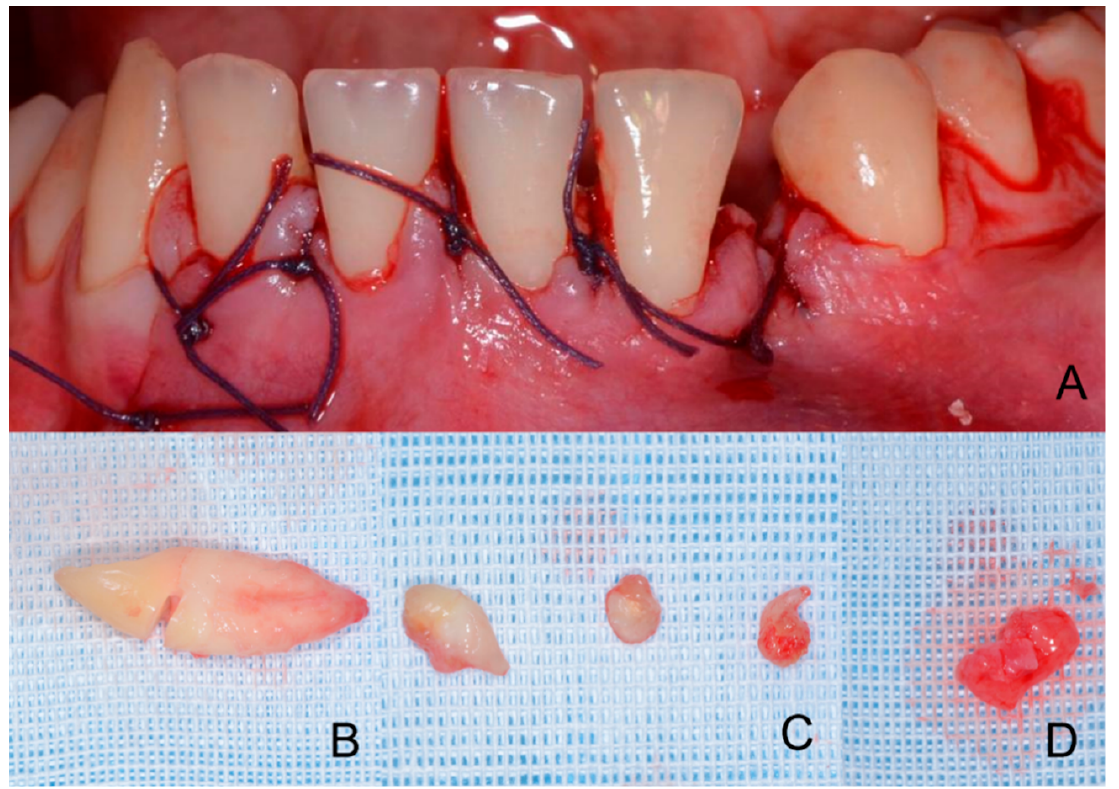
Figure 13. Post-operative images. ( A ) Frontal intraoral image with the suture of the flap (Vicryl Ethicon 3.0, 22 mm 1/2c, Johnson & Johnson International, Hamburg, Germany); ( B ) Image of the extracted canine; ( C , D ) The four extracted denticles which were part of the odontoma.